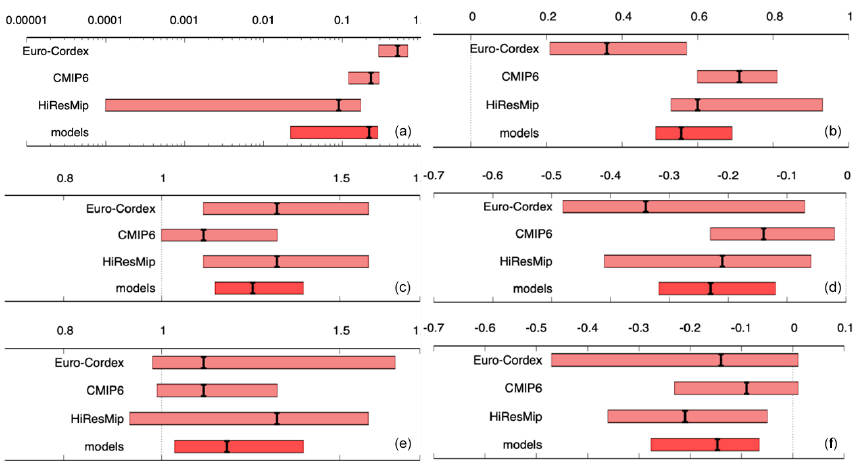
Figure 9. Projected changes between the present and + 2 ◦ C climate. Summary of results for probability ratio (a, c, e) and change in intensity [ ◦ C] (b, d, f) in the three indices TNnApr–Jul (a, b) , TNnGDD250 (c, d) and TNnGDD250-350 (e, f) . Extent of the bars gives two-sided 95% confidence intervals accounting for variability within the datasets, with the black marker indicating the best estimate. A weighted average of the results is shown in bright